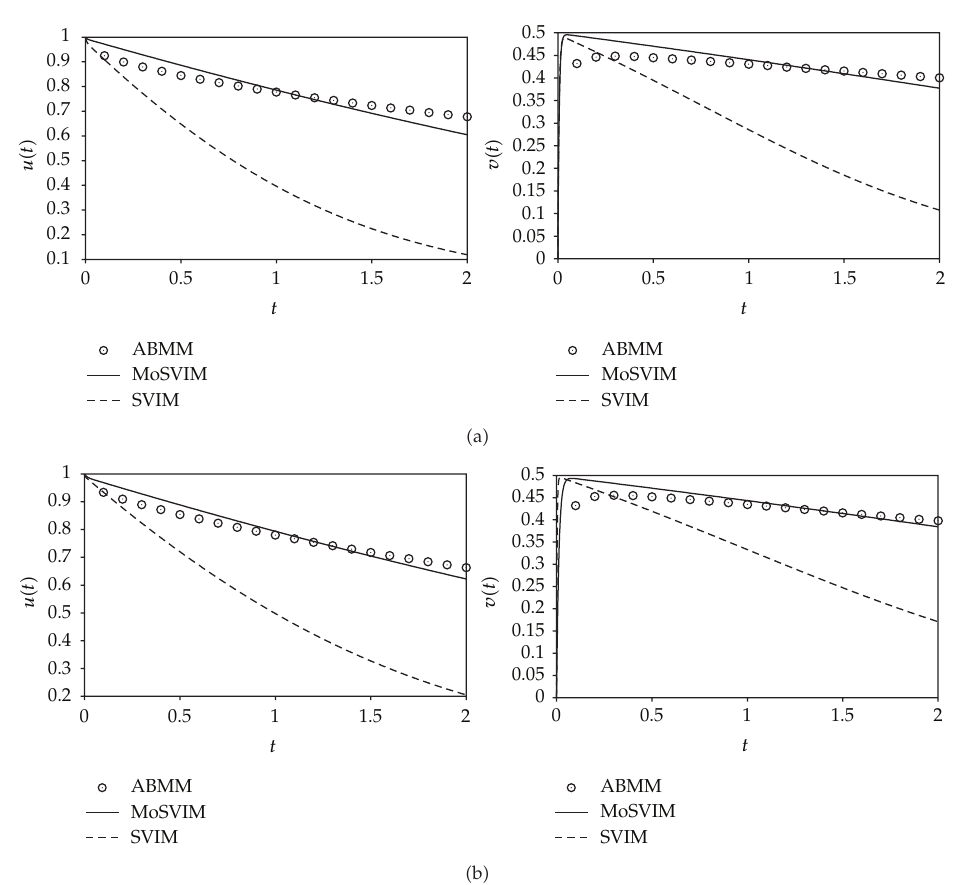
Figure 2: Approximate solution of fractional biochemical reaction model via the fifth iterate MoSVIM, (cid:9) 0 . 25; (cid:3) a (cid:4) θ (cid:9) 0 . 7, (cid:3) b (cid:4) θ (cid:9) 0 . SVIM and ABMM with di ff erent value of (cid:0)